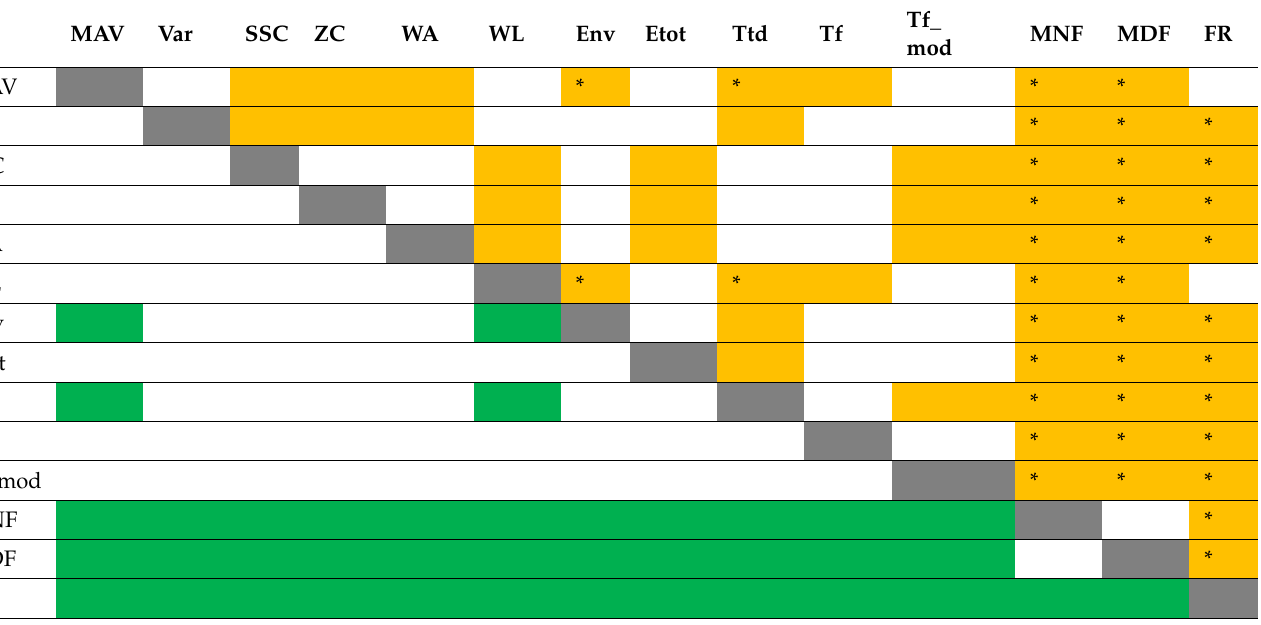
Figure 4. RMSE metric for all methods. These data comprise all subjects and all joint force estimates (except for the channels labeled as “poor”, see [24]). Table 4. Statistical significance between algorithms for both RMSE and cross-correlation. Green indicates statistically significant difference ( p < 0.05; Bonferroni-corrected) for the RMSE metric and orange indicates significant difference ( p < 0.05; Bonferroni-corrected) for the cross-correlation metric. The cases of significant differences for both metrics are marked with * on the cross-correlation part of the table. Grey indicates diagonal